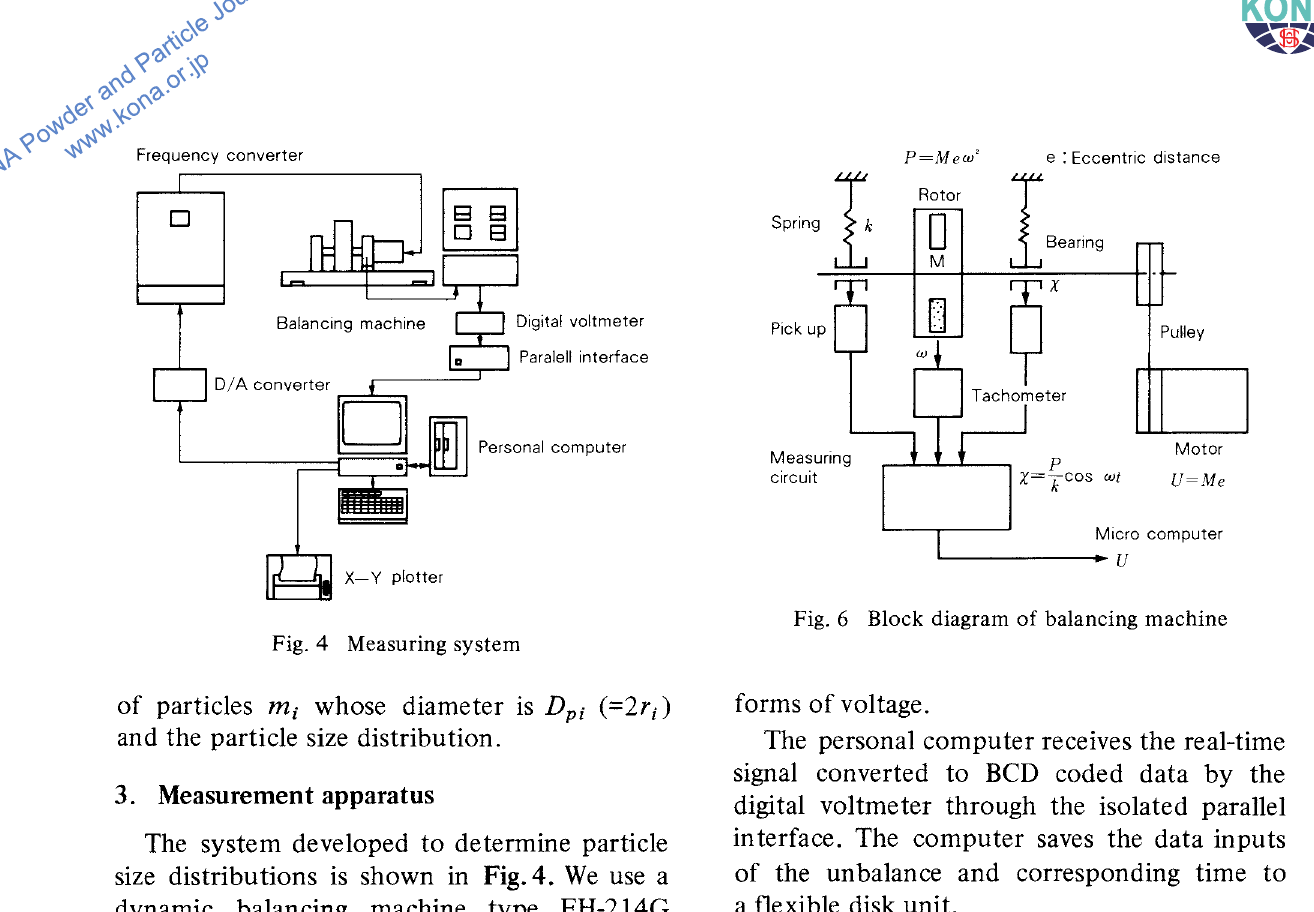
Fig. 6 Block diagram of balancing